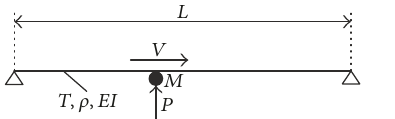
Figure 9: A concentrated mass moving at a constant forward speed along the beam [6].